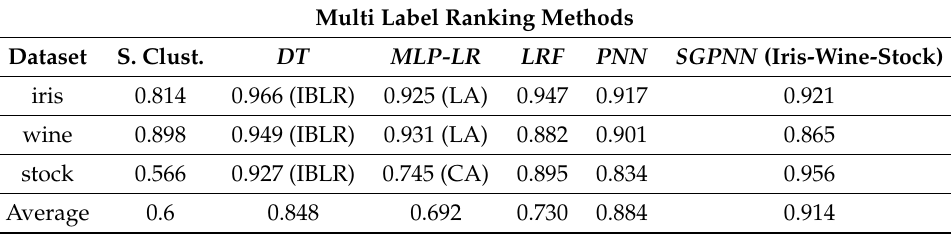
Table 5. Performance comparison of SGPNN , PNN and state-of-the-art label ranking approaches. Multi Label Ranking